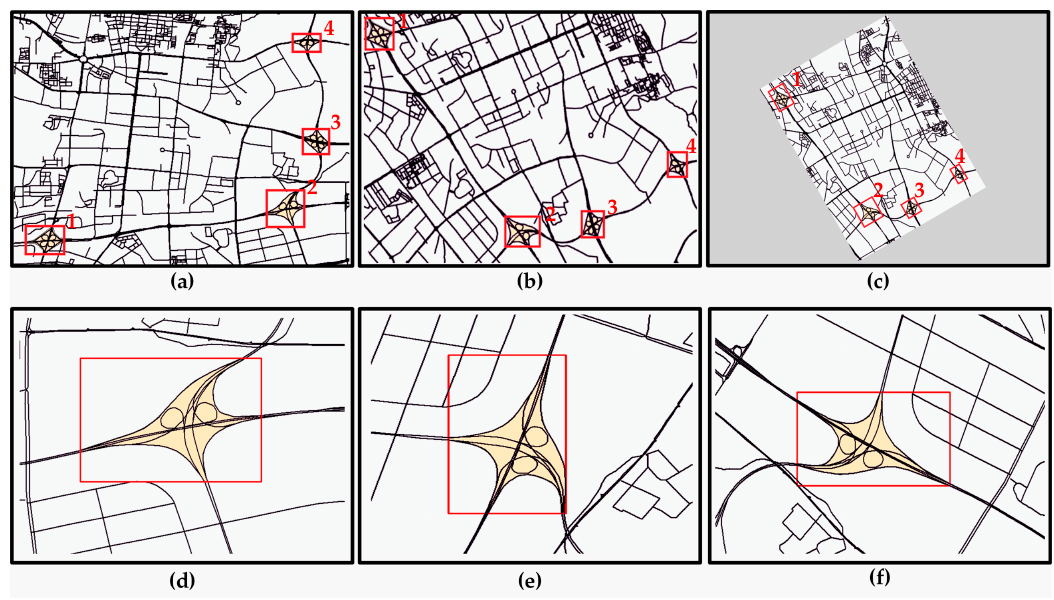
Figure 3. Generated training samples: ( a ) without any rotation; ( b ) with 125 ◦ vector rotation; ( c ) invalid margin appears with 75 ◦ raster rotation; ( d ) an amplified overpass and its minimum enclosing rectangle (MER); ( e ) the same overpass with 120 ◦ rotation and its novel MER; ( f ) the same overpass with 150 ◦ rotation and its novel MER.